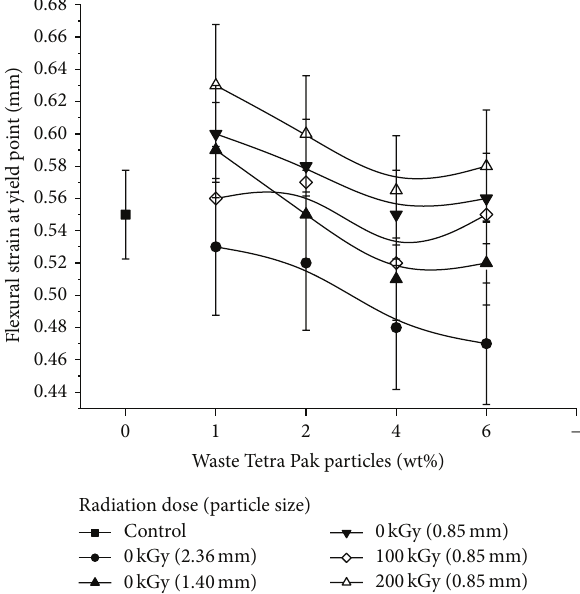
Figure 6: Flexural strain at yield point of concrete containing waste Tetra Pak